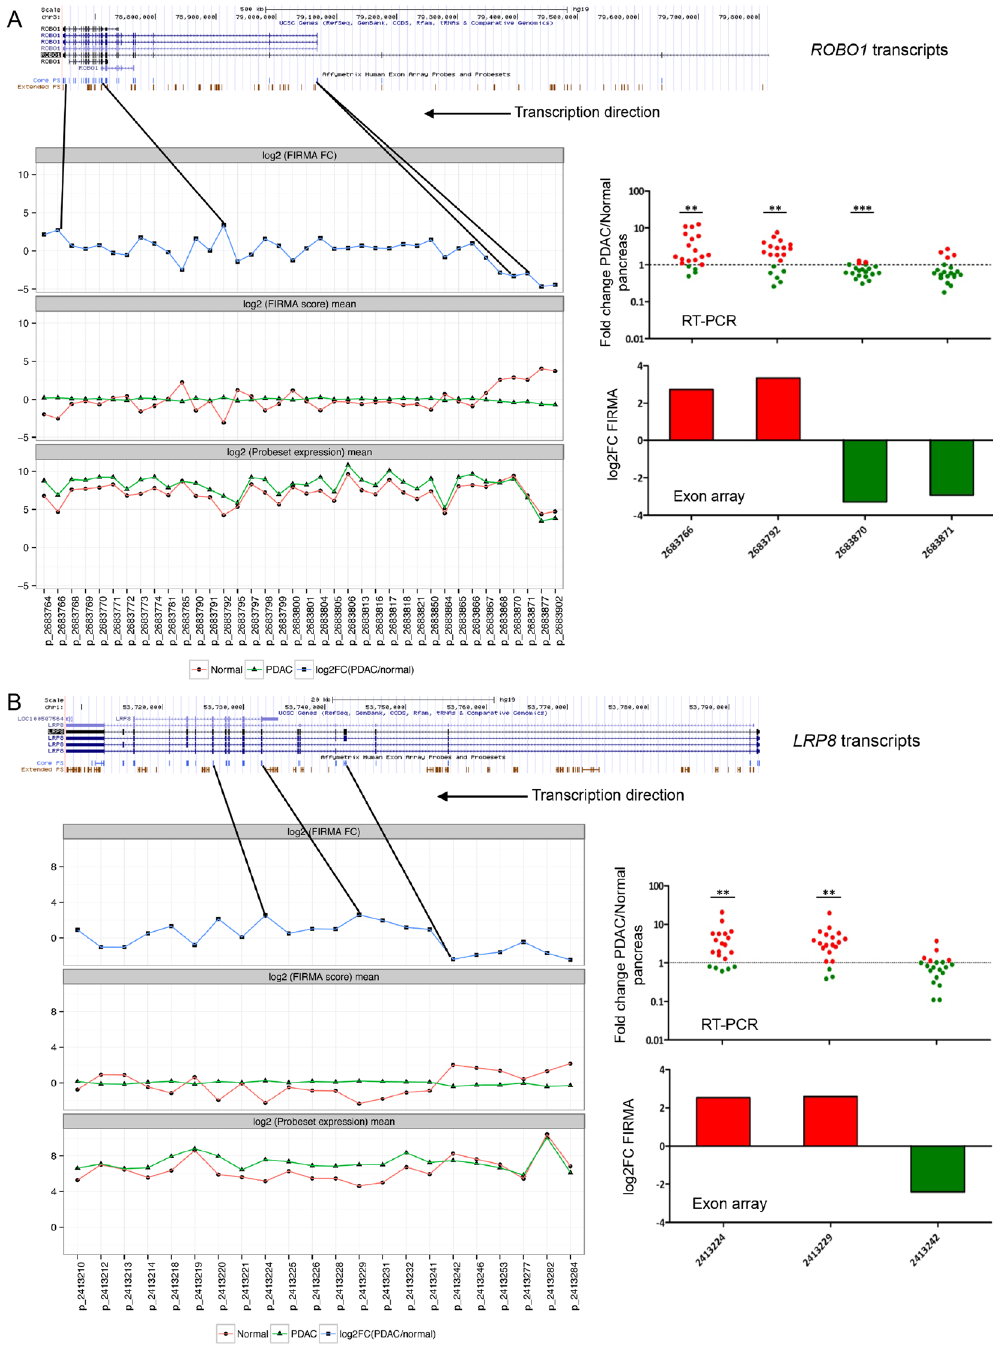
Figure 5. Analysis of multiple splicing events for ROBO1 and LRP8 , and validation with RT-PCR. ( A ) Alternative splicing for ROBO1 . ( B ) Alternative splicing for LRP8 . The UCSC transcripts are shown at the top. For all quantified core probe-sets, means for probe-set expression and FIRMA values (log 2 scaled), and the log 2 FIRMA fold changes (PDAC/normal) were shown underneath UCSC transcripts. The probe-sets chosen for RT-PCR validation were shown with the black solid lines, with their positions within the transcripts indicated. RT-PCR results for the chosen probe-sets are represented as scatter dot plots of expression fold change in PDAC compared to normal pancreas, with the significance level shown at the top ( * < 0.05, ** < 0.01, *** < 0.001). Corresponding exon array results are also reported in histograms of log 2 FIRMA fold change (PDAC/normal) values. Both ROBO1 and LRP8 are coding for cell-surface proteins, and both were transcribed in the reverse